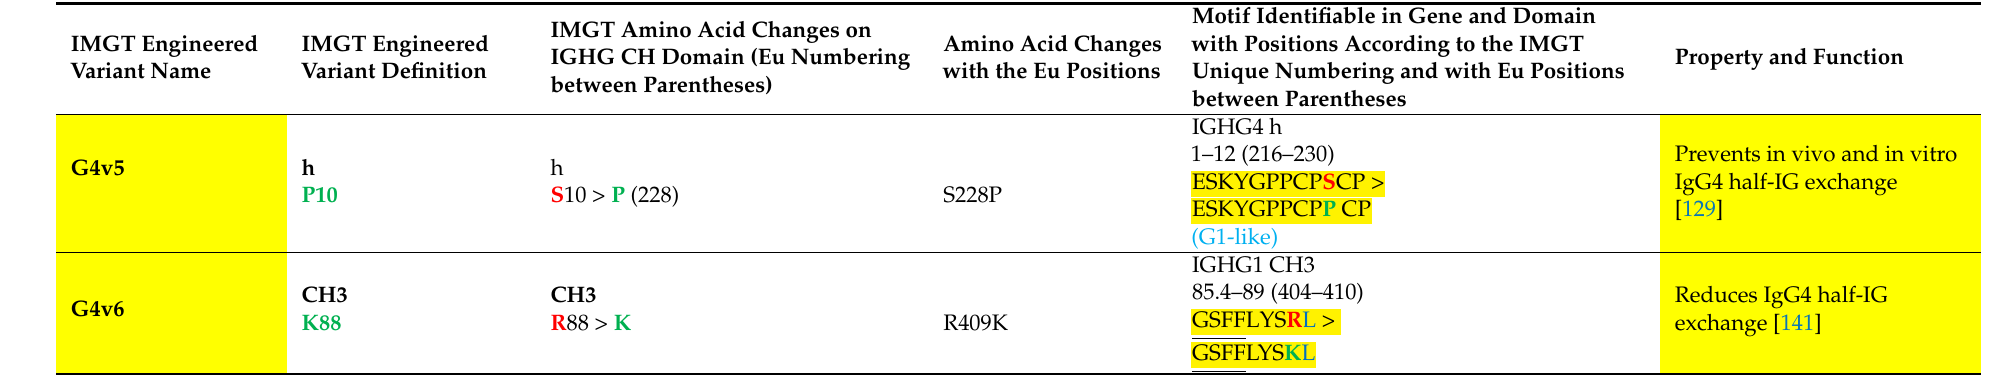
Table 16. IMGT nomenclature, Eu positions and IMGT motif of engineered Fc variants involved in the prevention of IgG4 half-IG exchange (Structure #12).